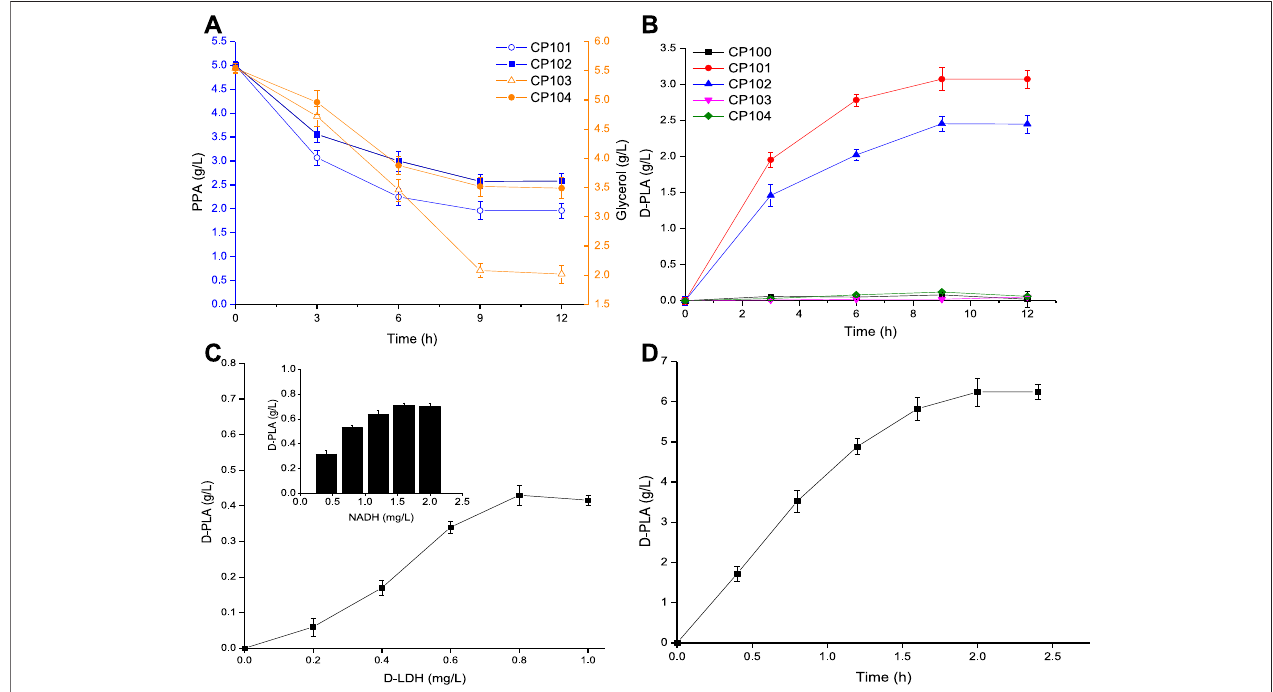
FIGURE2|(A) TimecourseoftheconsumptionofPPA(byCP101,CP102),andglycerol(byCP103,CP104); (B) TimecourseoftheproductionofPLAbyCP100, CP101,CP102,CP103,andCP104; (C) TheeffectofD-LDHandNADHconcentrationonD-PLAtiter; (D) TimecourseoftheproductionofD-PLAbyenzymecatalysis. Data are means ± SD ( n (cid:1)